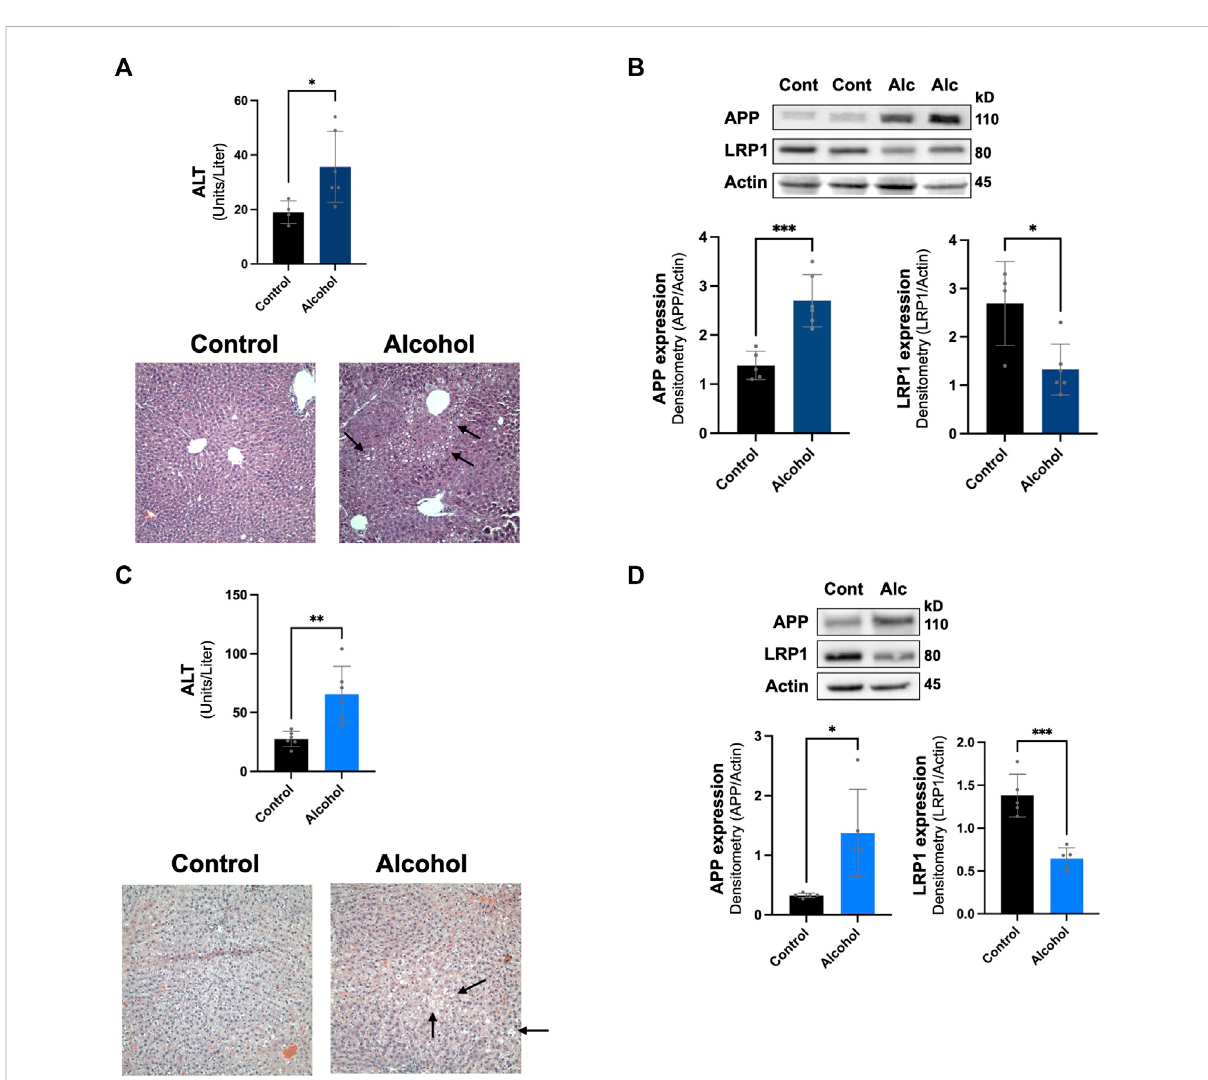
Effect of other alcohol feeding models on hepatic LRP1 and APP levels. The effect of the NIAAA binge model on liver injury and steatosis (A) , in addition to LRP1 and APP expression in the liver (B) . ALT, H&E histology (×200 magni fi cation), and immunoblotting of mice liver occurred following NIAAA bingemodel (6 weeks oralalcoholfeeding plusabinge).The arrows pointto lipid dropletsintheliverassociated with steatosis. n =4 – 6mice. The effect of intragastricalcohol feeding to rats on liver injuryand steatosis (C) , and hepatic LRP1 and APP expression inintragastric alcohol fed rats (D) . ALT, H&E histology, and immunoblotting of rat liver occurred following 6 weeks of intragastric alcohol feeding to rats ( n = 5 rats). Densitometry for APP and LRP1 in the liver was performed using NIH Image J with β -actin being used as the loading control. Results are mean ±